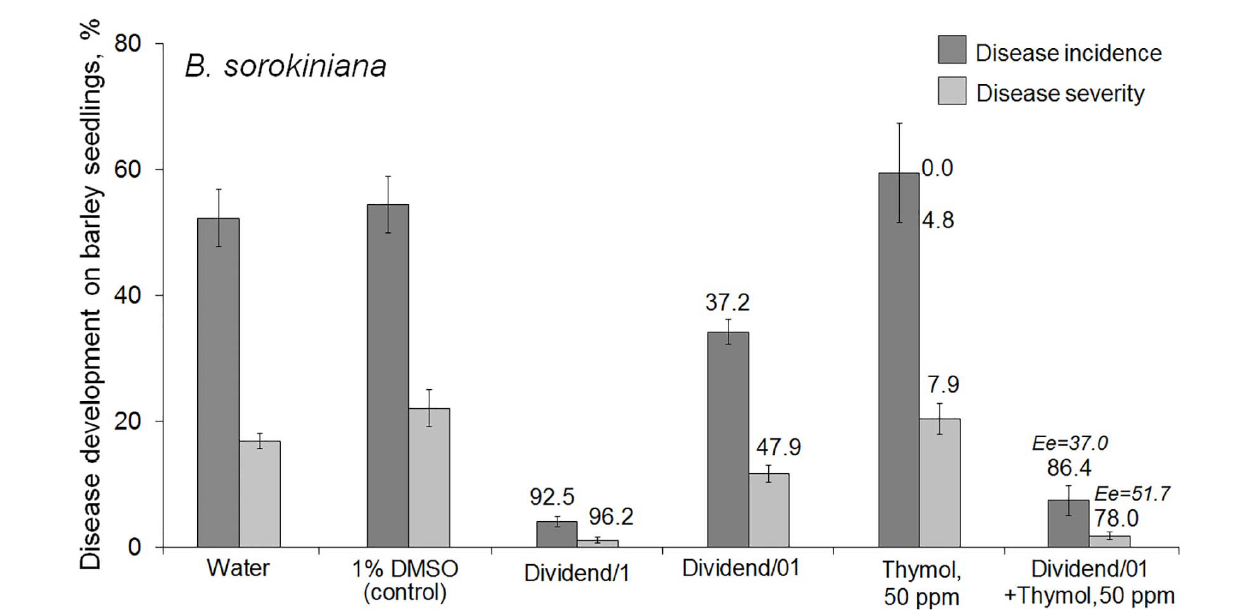
FIGURE 1 | Effect of seed treatments with Dividend R (cid:13) alone, thymol alone or their combination on the development of a root rot agent, Bipolaris sorokiniana , on spring barley seedlings (cv. Zazersky 85). Dividend/1, the fungicide dosage recommended for industrial seed treatments. Dividend/01, the fungicide dosage ten times lower than recommended. In treatments involving thymol, it was used as a solution in 1% dimethyl sulfoxide (DMSO). Numbers in regular font above the columns show percent disease suppression observed in experiments (Er). Percent suppression calculated for expected additive effect (Ee) is indicated with italic numbers (see section “Materials and Methods,” “Data Analysis and Statistics”). Disease incidence was determined as the average percent of rotted seedlings compared to DMSO-treated controls. Disease severity was calculated by formula: R% = (cid:54) (n × d)/4N × 100, where n – the number of seedlings with the same disease index; d – the disease index according to a score rating scale (from 0 to 4); N – the number of seedlings per treatment; 4 – the maximal score in the scale (Shcherbakova et al., 2018). Results are expressed as the means of three independent roll-towel assays, 200 seeds per treatment in each assay. Y-bars show SE with a 95% confidence interval ( p ≤ 0.05, t -test for independent variables; STATISTICA v. 6.1, StatSoft